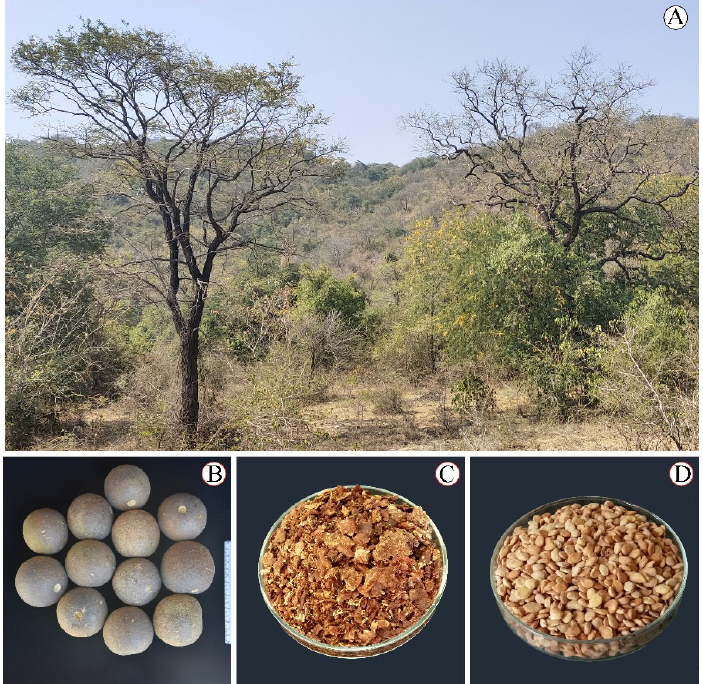
Figure 1. Wood apple ( Limonia acidissima L.)—Tree habit ( A ), fruits ( B ), pulp ( C ), and seeds ( D